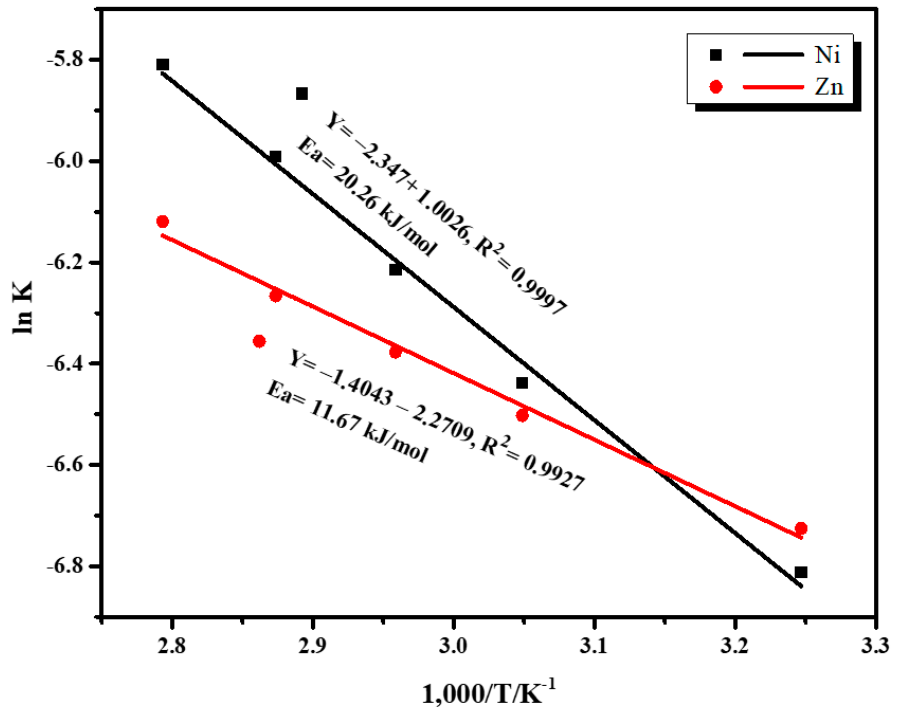
Figure 18. Arrhenius plot for nickel and zinc leaching from WLSR residue.